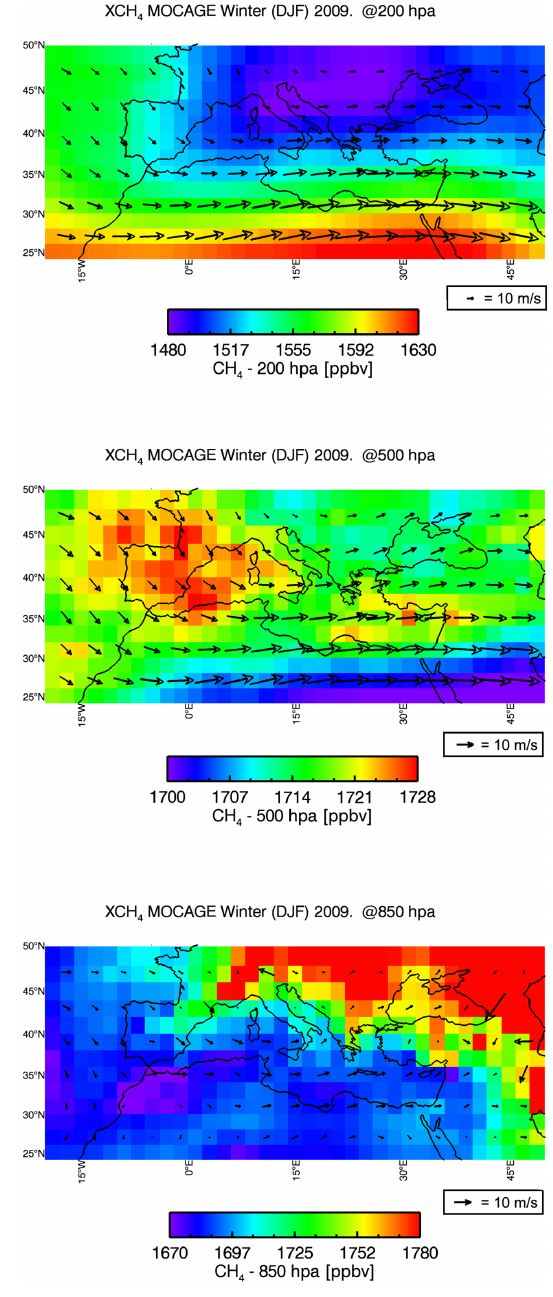
Figure 3. As Fig. 1, but for winter (DJF)